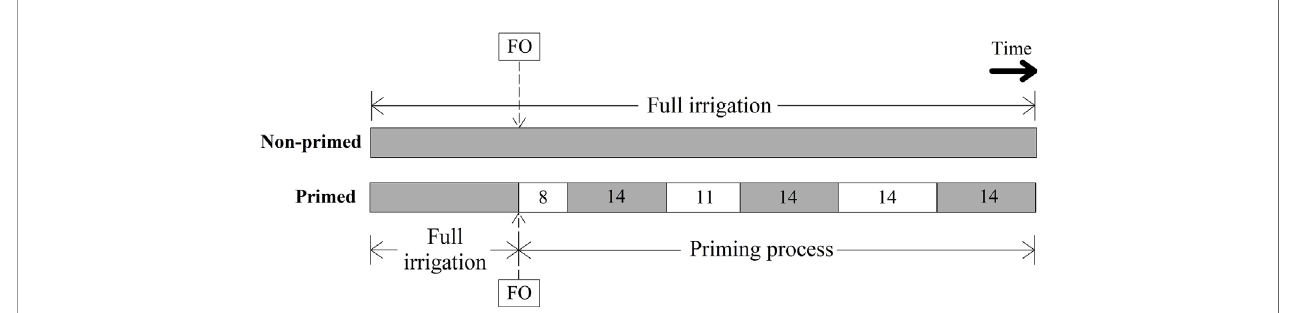
FIGURE 1 | Timeline representation for the watering treatments per accession: non-primed plants (no water restriction) and primed plants (water restriction periods). Gray and white blocks mean substrate watering with full irrigation or no irrigation, respectively. Duration of every period during the priming process is indicated in days within the blocks. The priming process started after fl owering onset